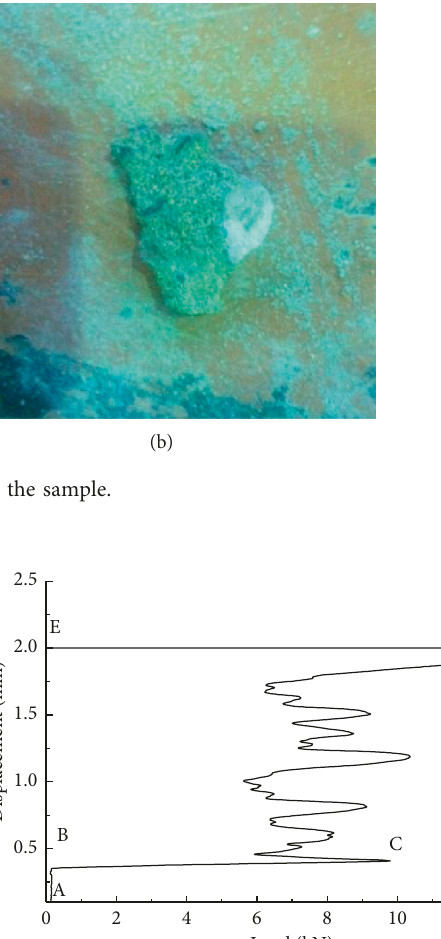
Table 5: Compressive strength loss rate after freeze-thaw.